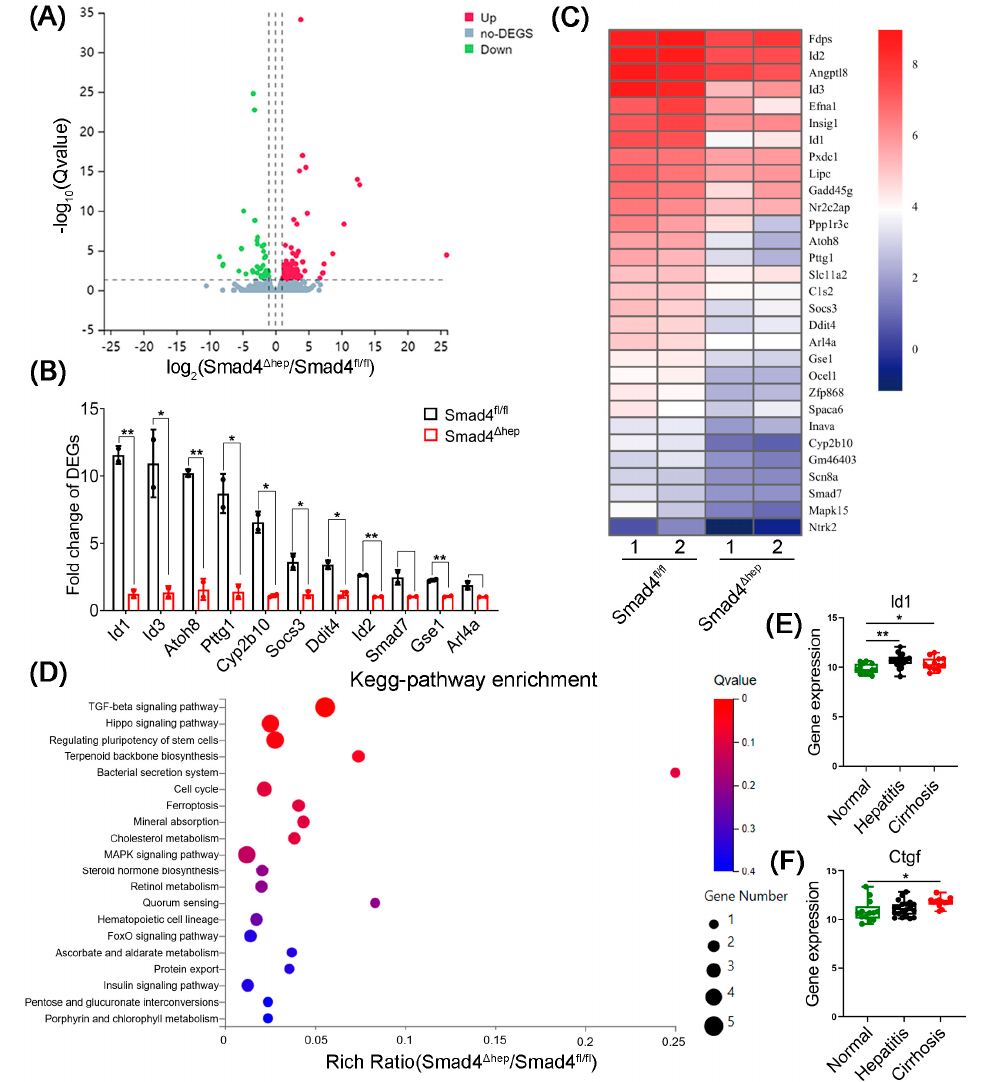
Figure 4. RNA sequencing analysis of DEGs in CCl 4 -induced liver fibrosis tissues. Smad4 fl/fl and Smad4 ∆ hep mice were treated with CCl 4 for 4 weeks to establish the liver fibrosis model. The fibrotic liver tissues of Smad4 fl/fl and Smad4 ∆ hep mice were analyzed by RNA sequencing ( n = 2 per group). ( A ) Volcano diagram of DEGs with p < 0.05. ( B ) Analysis of fold change in DEGs. ( C ) Heatmap of the expression of the most significantly downregulated genes. ( D ) The analysis of the related signal pathways of downregulated genes by KEGG. ( E , F ) The analysis of ID1 and CTGF expression in liver tissues from patients with hepatitis and cirrhosis in the GSE89377 dataset. Normal, n = 13; Hepatitis, n = 20; Cirrhosis, n = 14. * p < 0.05, ** p < 0.01.